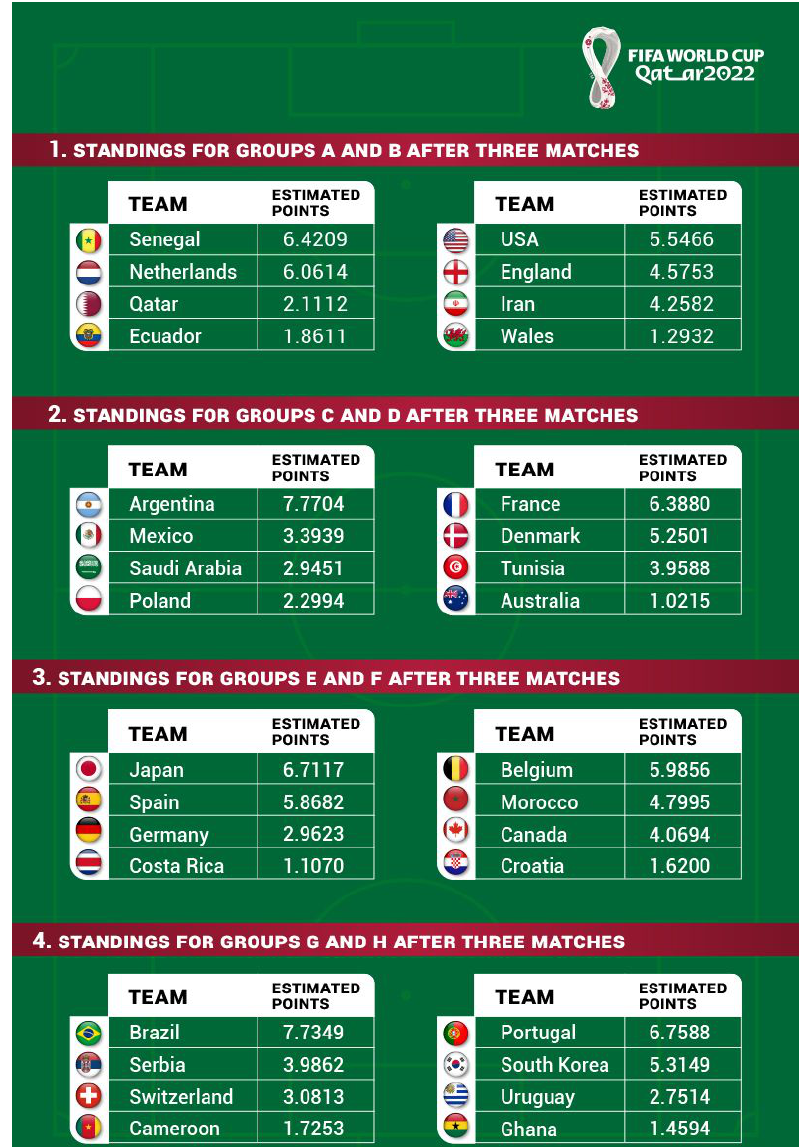
Figure 9. Final standings for the first